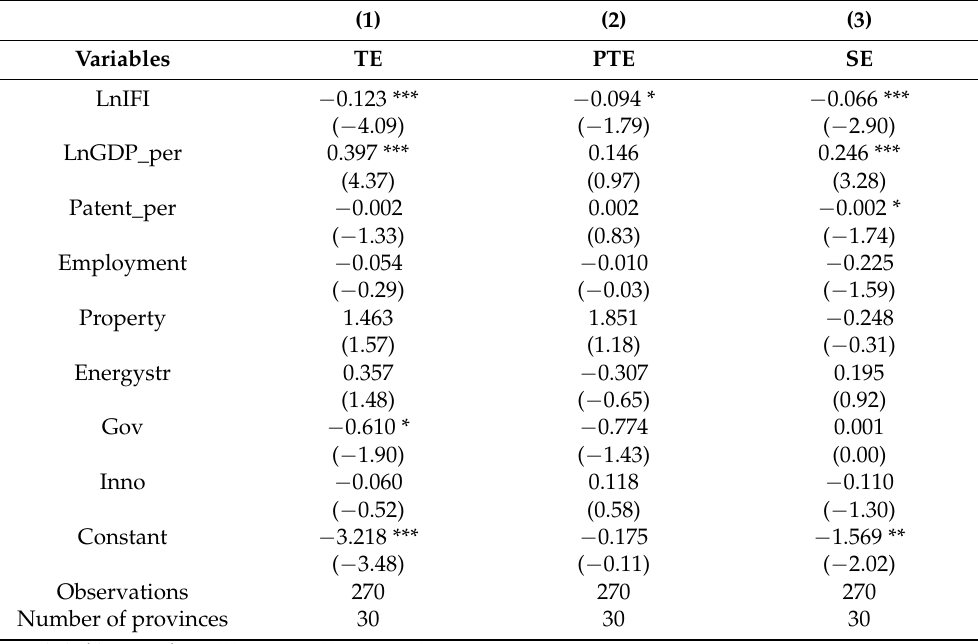
Table 10. Decomposition of technical efficiency.